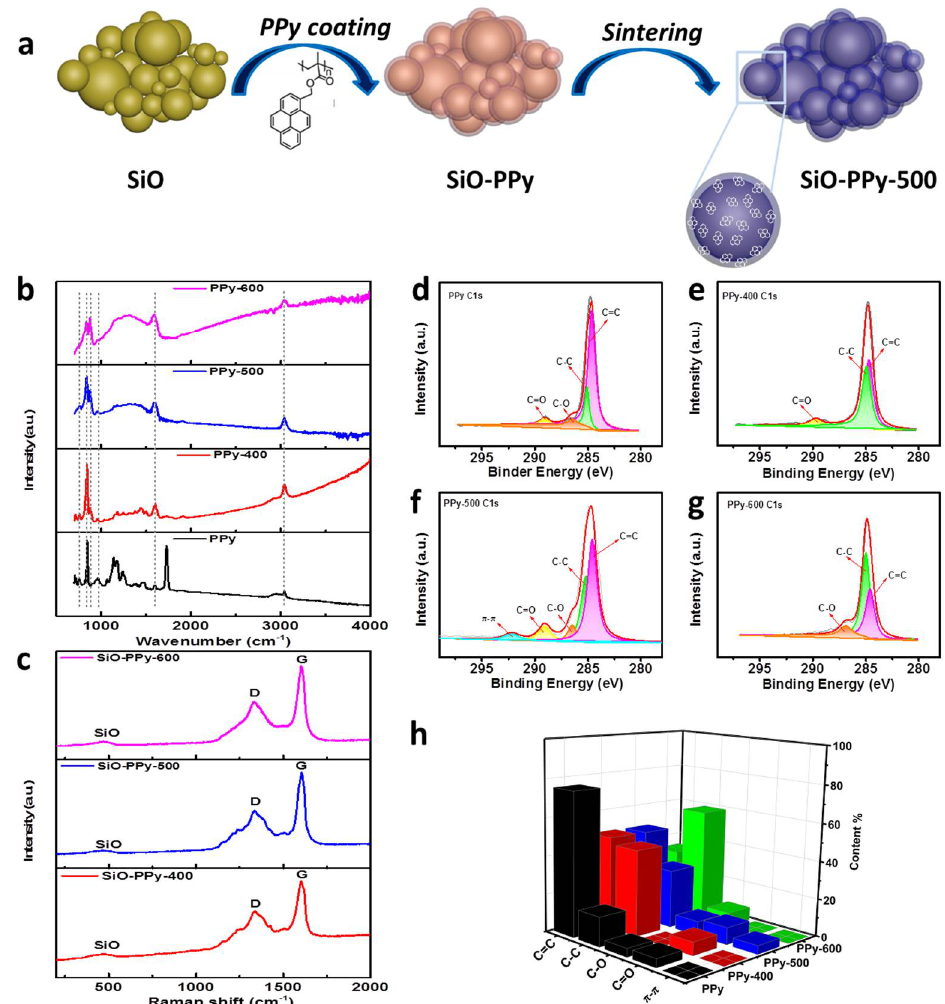
Figure 1. ( a ) Schematic illustrating the synthesis process of the SiO-PPy composite material sintered at different temperature; ( b ) Attenuated Total Reflectance Fourier transform infrared (ATR-FTIR) spectra of untreated PPy and PPy pyrolyzed at 400–600 °C; ( c ) Raman spectra of SiO-PPy treated at 400, 500, and 600 °C; ( d – g ) x-ray photoelectron spectroscopy (XPS) spectra; and ( h ) the corresponding carbon bonding composition of untreated PPy and PPy pyrolyzed at 400–600 °C.